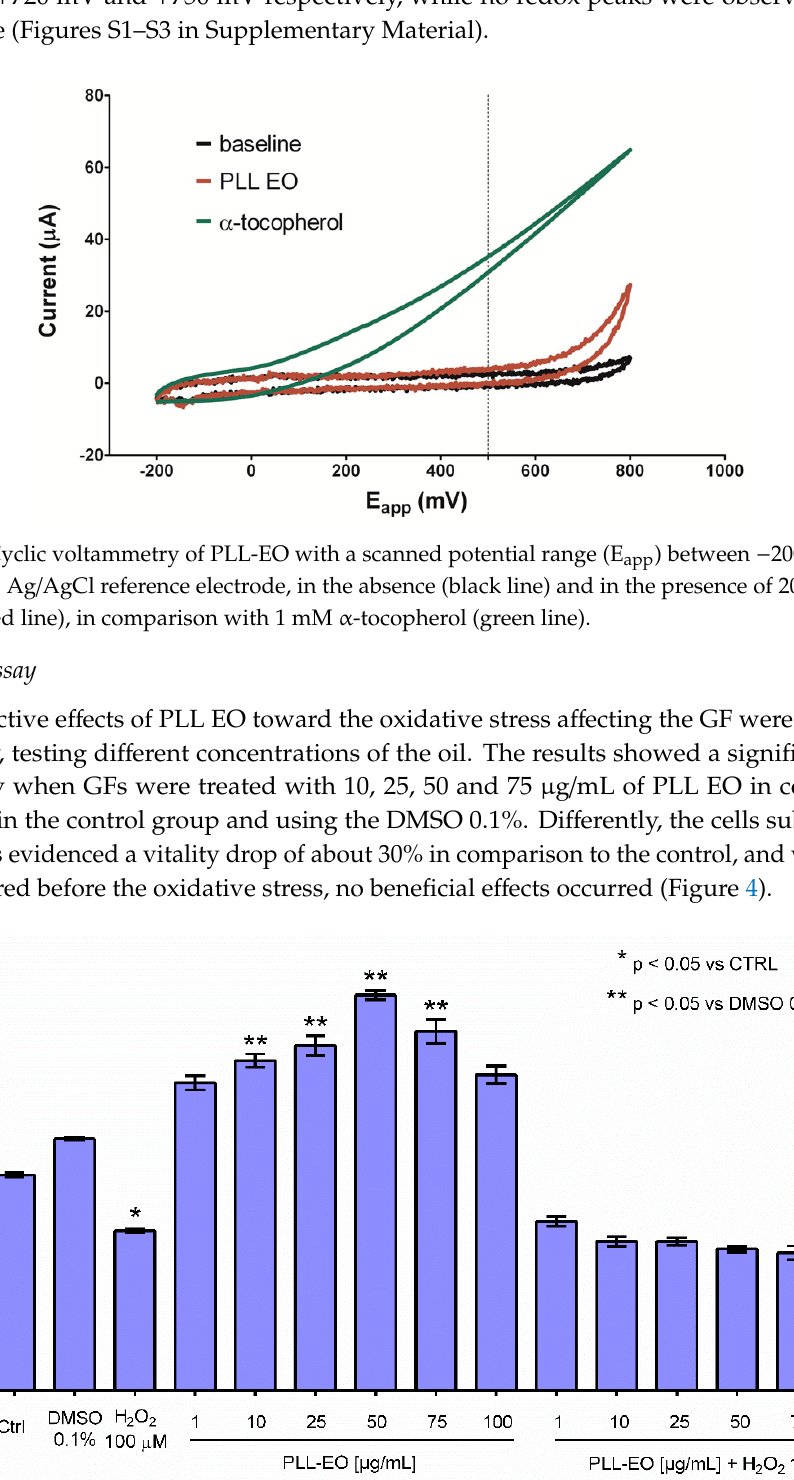
Figure 4. Primary gingival fibroblasts viability relative to the sole growth medium (CTRL), if supplemented with 0.1% DMSO or 100 µM H 2 O 2 and when amended with PLL EO - H 2 O 2 and PLL- EO + H 2 O 2 . The separation of mean values (n = 4) and standard deviation were calculated according to the Student-Newman-Keuls test at p ≤